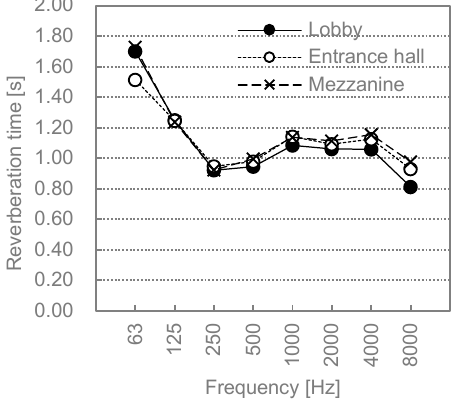
Figure 12. The frequency characteristics of the reverberation time of each one octave band of each room.